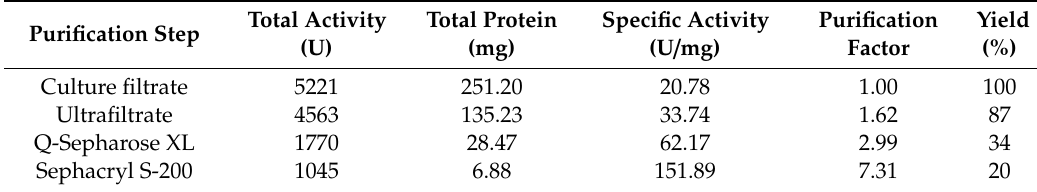
Table 1. Purification of recombinant